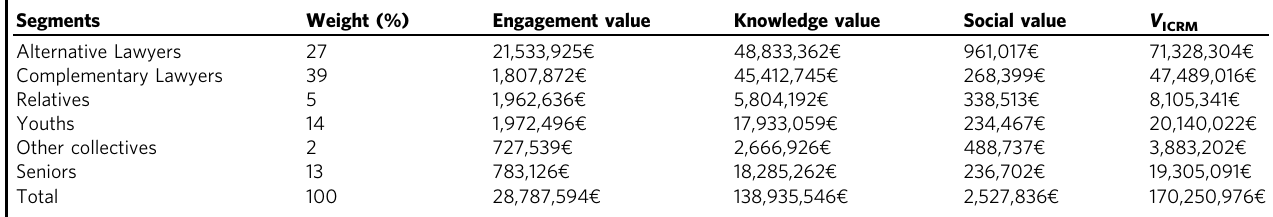
Table 5 Model results according to customer archetypes.